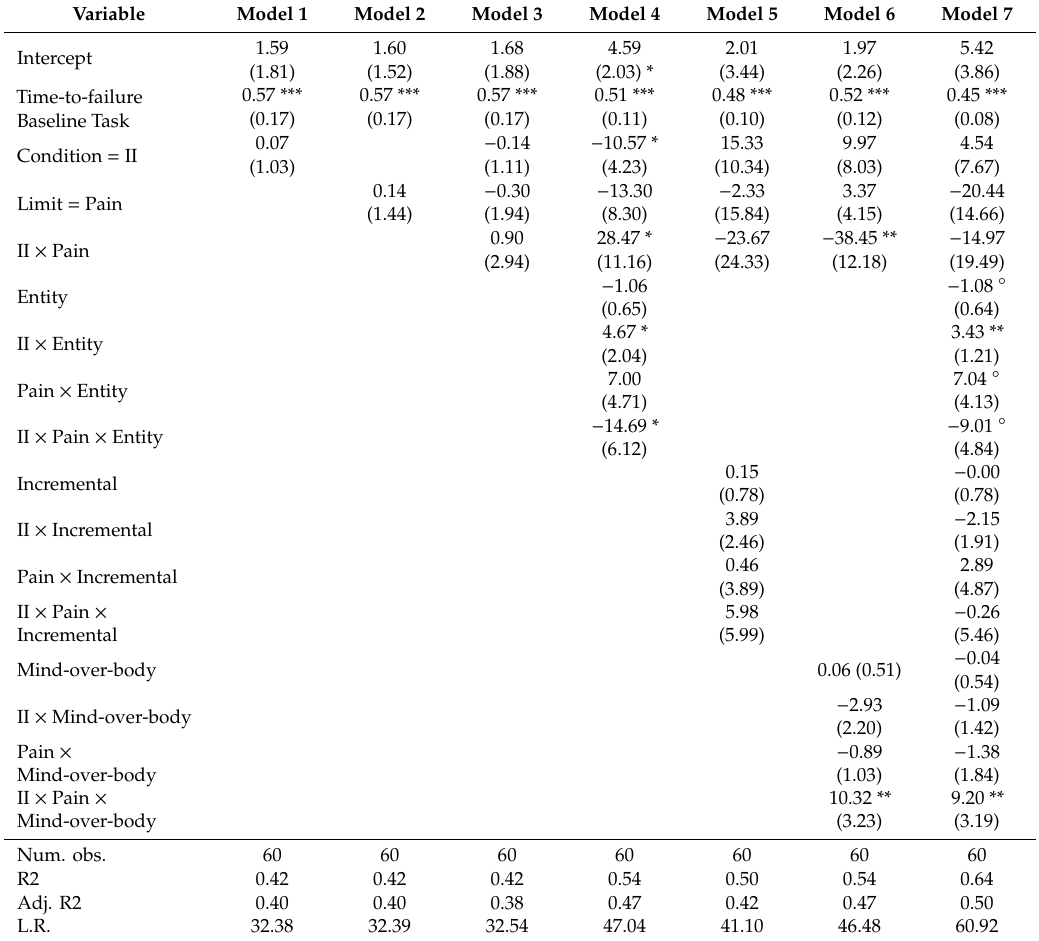
Table2. Linearregressionmodelsforexplainingtime-to-failureinthemaintaskoftheHRT.Theintercept represents the expected time-to-failure in the main task when all other predictors equal 0. Numbers in parentheses are robust standard errors. Baseline: Condition = Goal Intention, Limit (reason for baseline task termination) =